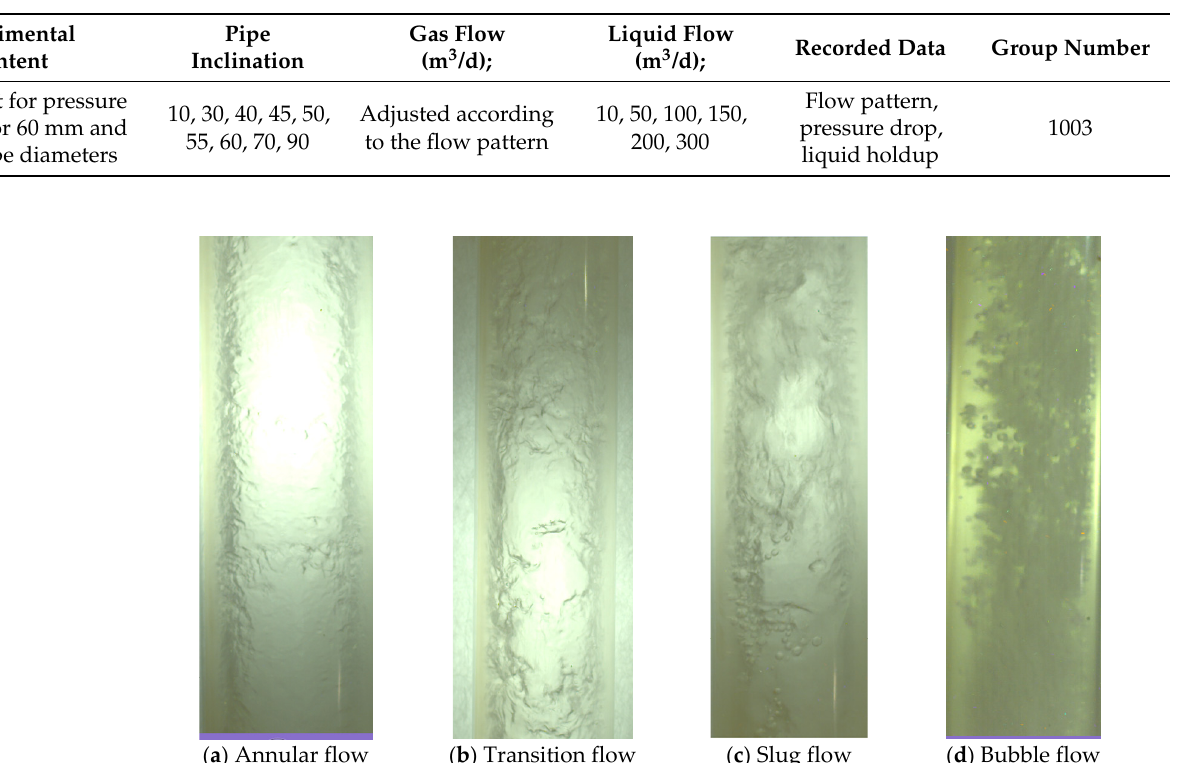
Table 1. Experimental scope.